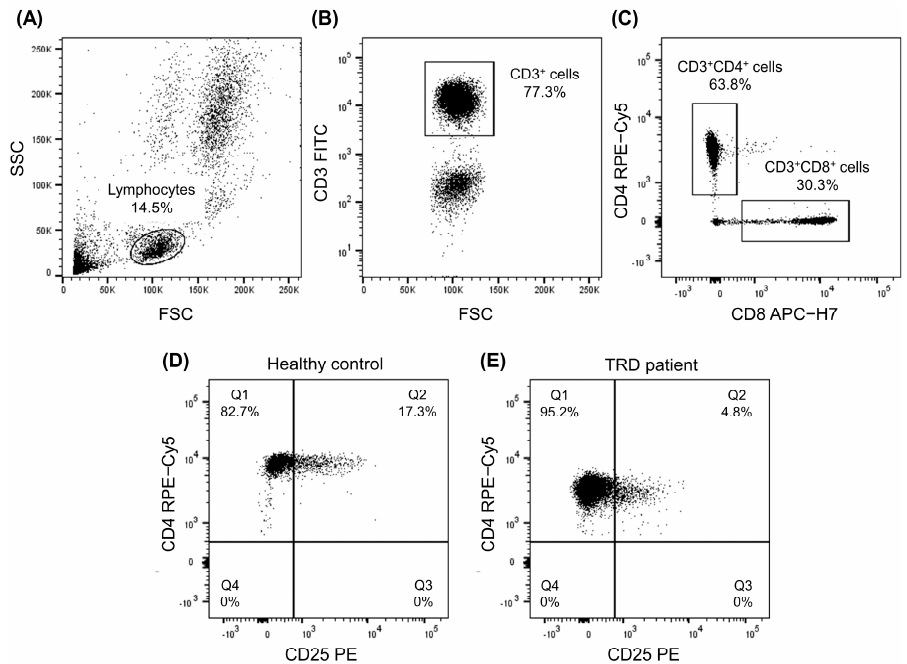
Figure 1. Cytometric analysis of T-cell subpopulations. Lymphocytes were selected based on forward- and side-scatter characteristics ( A ). Then, T cells were identified based on their positivity for the CD3 antigen ( B ). Next, helper T cells were identified based on the expression of the CD4 antigen and cytotoxic T cells based on CD8 expression ( C ). Finally, subpopulations expressing different activation antigens, e.g., the CD25 antigen, were identified. Exemplary dot plots with CD4 + CD25 + cells from a healthy donor ( D ) and from a TRD patient ( E ).